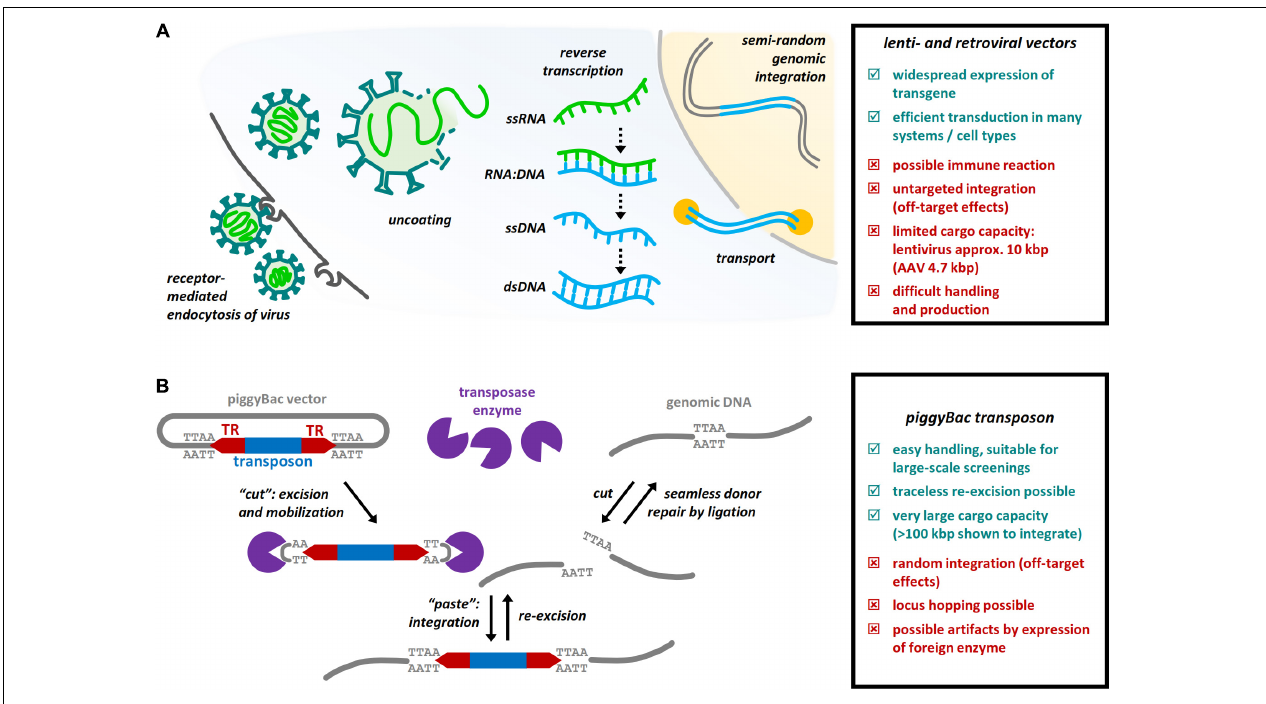
FIGURE 1 | Common methods of genome editing in neural stem cells in vivo . (A) Retro- or lentiviral transduction. The virus is introduced by receptor-mediated endocytosis depending on the pseudotype of the capsid, which is then degraded to uncoat the viral genome. This is retrotranscribed from ssRNA to dsDNA, transported to the cell’s nucleus and integrated into the genome, with preferred integration sites dependent on the type of virus. (B) Integration of the piggyBac transposon. In the presence of its specific transposase, the piggyBac transposon can be integrated to the genome in a “cut-and-paste” manner. TTAA motifs in the terminal repeats (TR) regions are recognized by the transposase which excises and mobilizes the transposon. The genomic DNA is cut at TTAA sites and the transposon is integrated by ligation. In the same way, the transposon can be re-excised, with a seamless re-ligation repairing the host’s donor site.